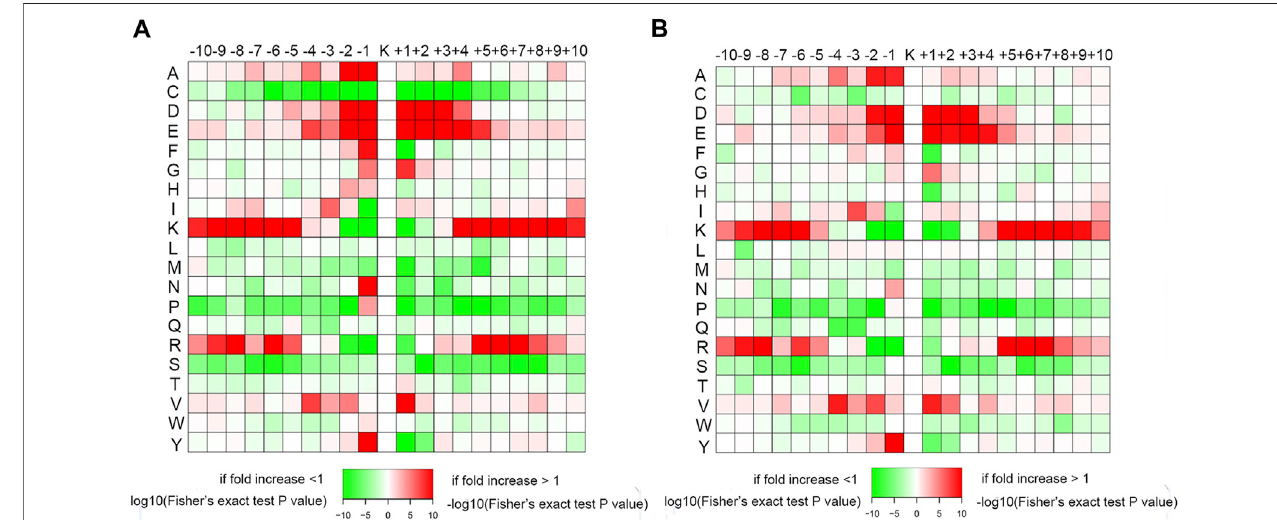
FIGURE7| HeatmapsofaminoacidsequencesaroundtheKcrresiduesinthe (A) conidialstageand (B) mycelialstage.Theredcolorrepresentsenrichment,and green represents depletion of amino acids at the speci fi c positions.